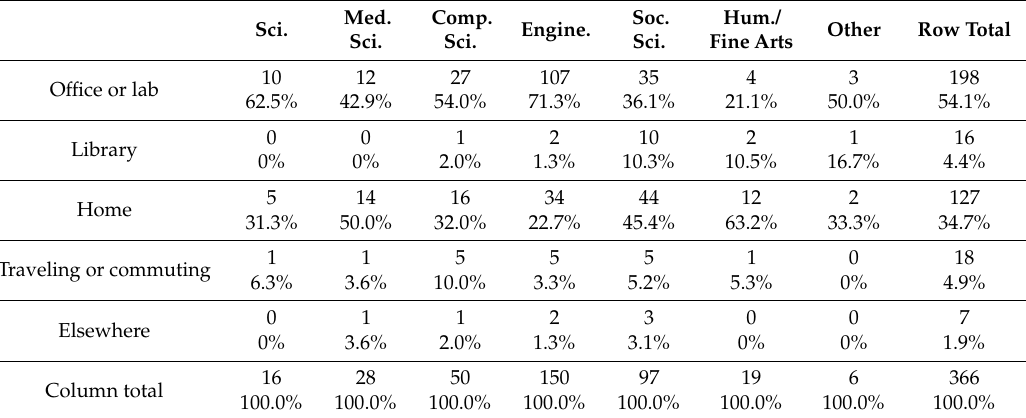
Table 22. Browsing patterns by subject disciplines grouped.